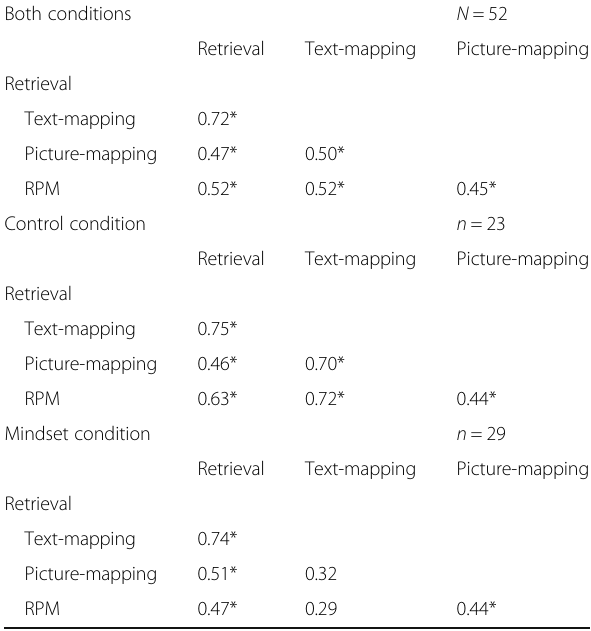
Table 1 Correlations ( r scores) between relational retrieval, ratings of the relational match passage in the text-mapping task, relational choices in the picture-mapping task, and Raven ’ s Progressive Matrices (RPM) scores for experiment 1 Both conditions N = 52 Retrieval Text-mapping